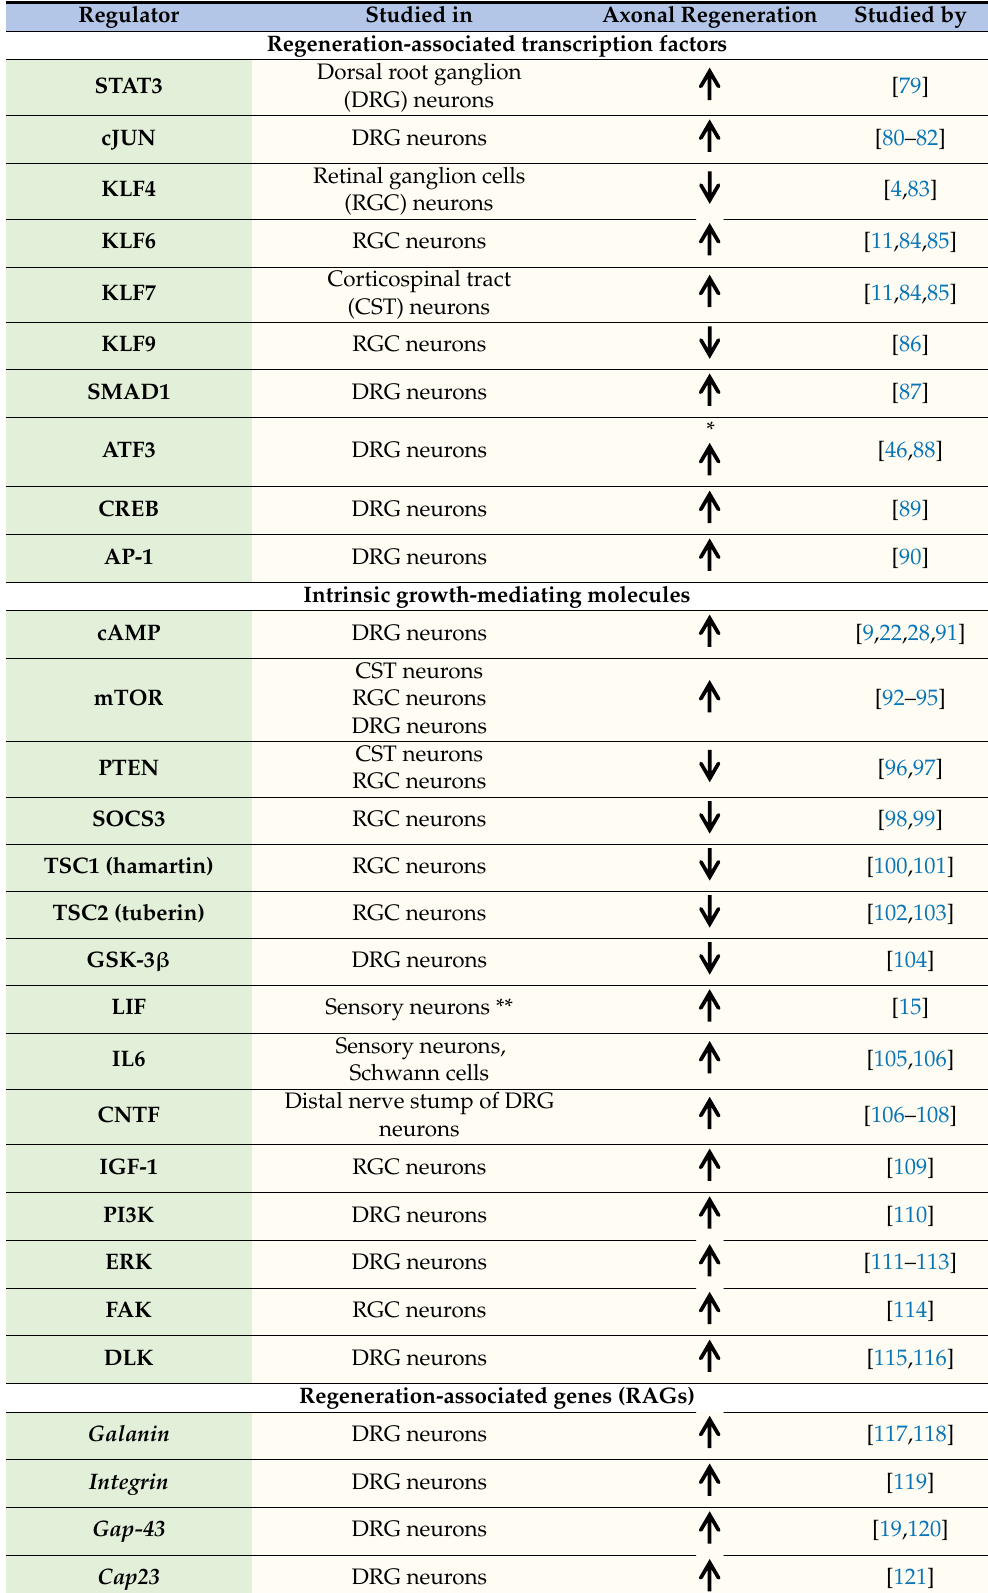
Table 1. Intrinsic regulators for axonal regeneration under injury condition. Regulator Studied in Axonal Regeneration Studied by Regeneration-associated transcription factors Dorsal root ganglion STAT3 cJUN DRG